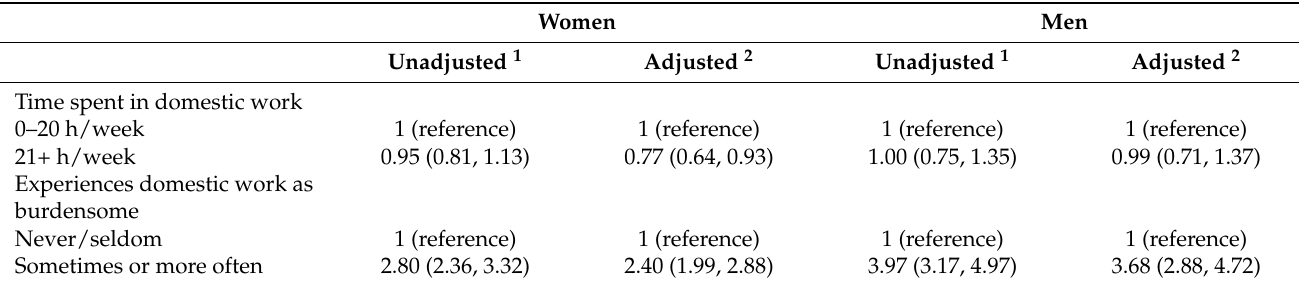
Table 2. Univariate and multivariate odds ratios (95% confidence interval in parenthesis) for self-reported diagnosed depression among women and men aged 30–69 years.